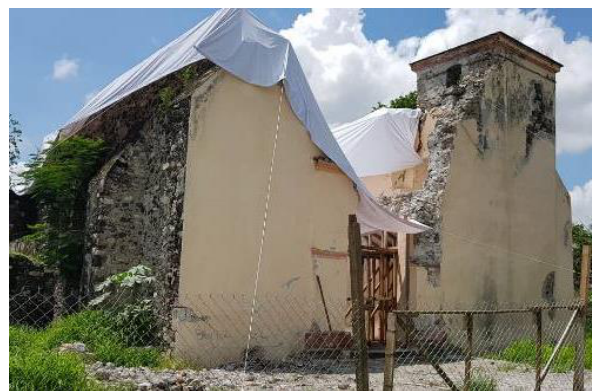
Figure 3. Colonial church damaged by the 2017 Puebla earthquake in Jojutla de Juárez, Morelos. Photo: Adrià Sánchez Calvillo